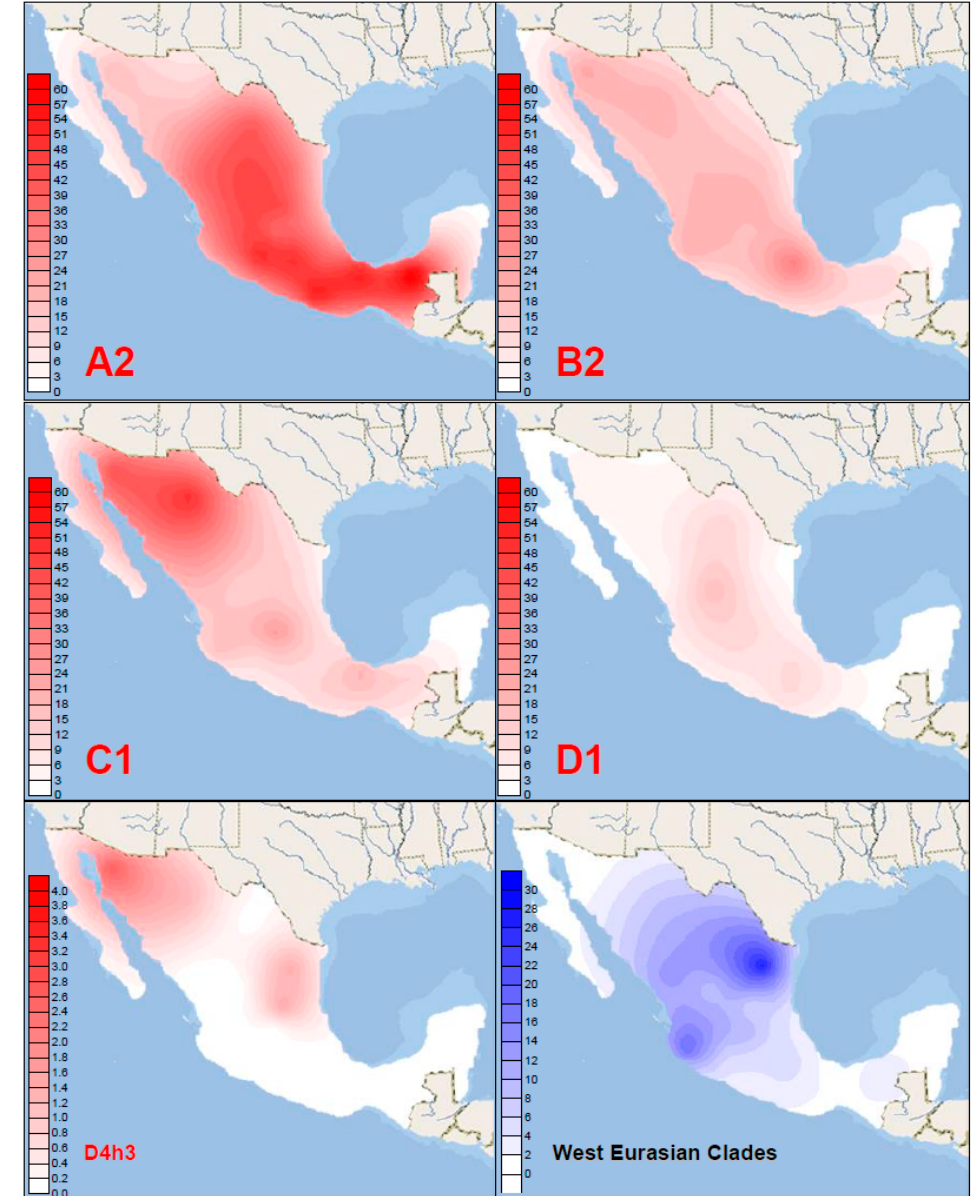
Figure 2. Spatial frequency (%) distributions of Indigenous American haplogroups A2, B2, C1, D1, and D4h3 and the combined West Eurasian lineages in Mexico. Both clines were also observed in Indigenous and admixed populations when ana- lyzed at a country-wide scale [2,3,12,14,17,18,62]. These findings illustrate the heterogeneity of lineage dispersal within America, since they contrast with the overall gradients in the double continent [8,18]. Haplogroup B2 (17.6%) was uniformly distributed in the North, Center, and South of Mexico in this sample (16.8–18.5%) with the slightly higher proportion particularly the Northwest (20.4%). A generally higher prevalence in admixed and Indige- nous Northern Mexican/Greater Southwest populations has been reported [2,6,14,17,63]. Haplogroup D1 (5.5%) was found to be relatively similarly distributed between the North (3.7%), Center (7.2%), and South (5.4%). Lower frequencies in the North were observed previously [14]. The rare D4h3 (mostly D4h3a) (0.6%) reached 1.6% in the North, particu- larly Northwest, while elsewhere did not exceed 0.6%. D4h3a spread into the Americas along the Pacific coast and is generally found there [4,10,54]. X2 (likely X2a; 0.1%) is a low-frequency (Northeastern) North American lineage [54] and the X2 haplotype